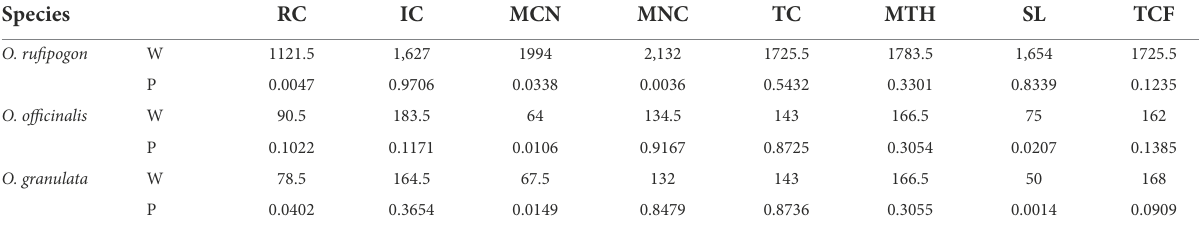
TABLE 1 p -Values generated from Wilcoxon Rank Sum test testing the difference of land use types area around populations. Species